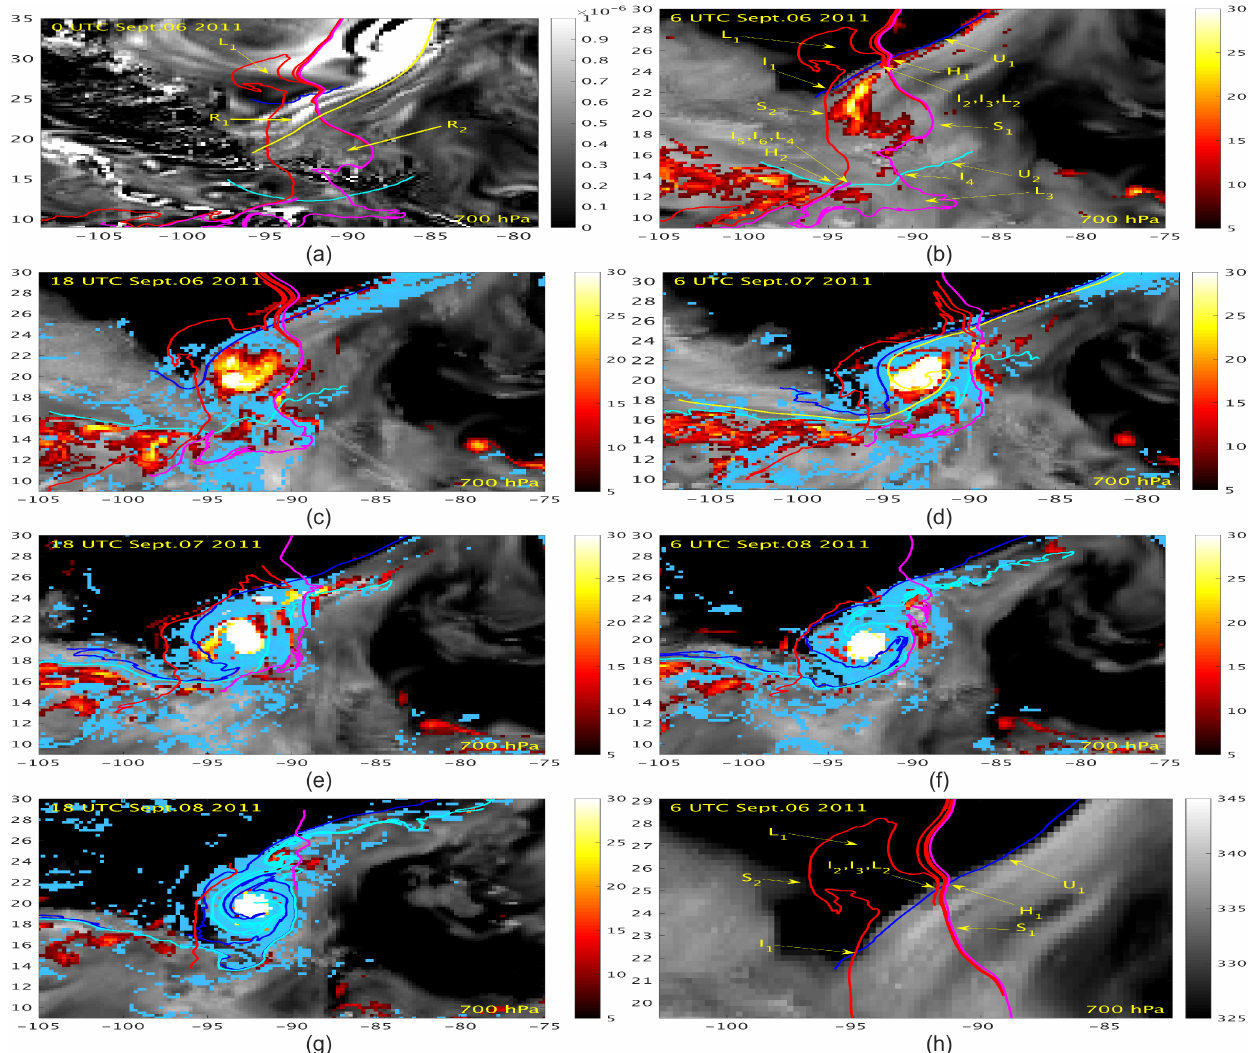
Figure 3. The stable (red, magenta) and unstable (blue, cyan) manifolds are overlaid on the ECMWF PV field (Km 2 kg − 1 s − 1 ) (a) and on the θ e field (K) (background with gray colors) at 700hPa (b–g) showing the time evolution of the manifolds from 6 to 8 September. The hot color map shows the ζ Lag values while the cool colors indicate OW Lag values of less than − 8 indicating high strain. Labels are provided in panels (a) and (b) . A zoom of the features that are shown in panel (b) is shown in panel (h) , which also shows the color bar for the θ e field. An attracting line from the Lee flow is shown in yellow in panel (a) , while the advection of that line is shown in panel (d)